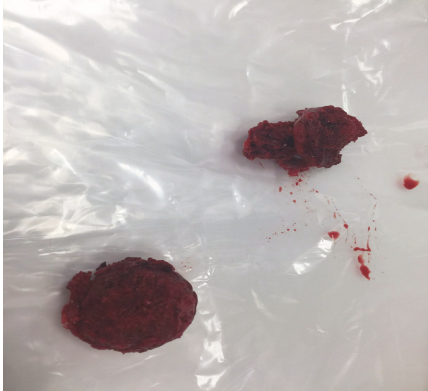
Figure 7: Necrotic femoral heads